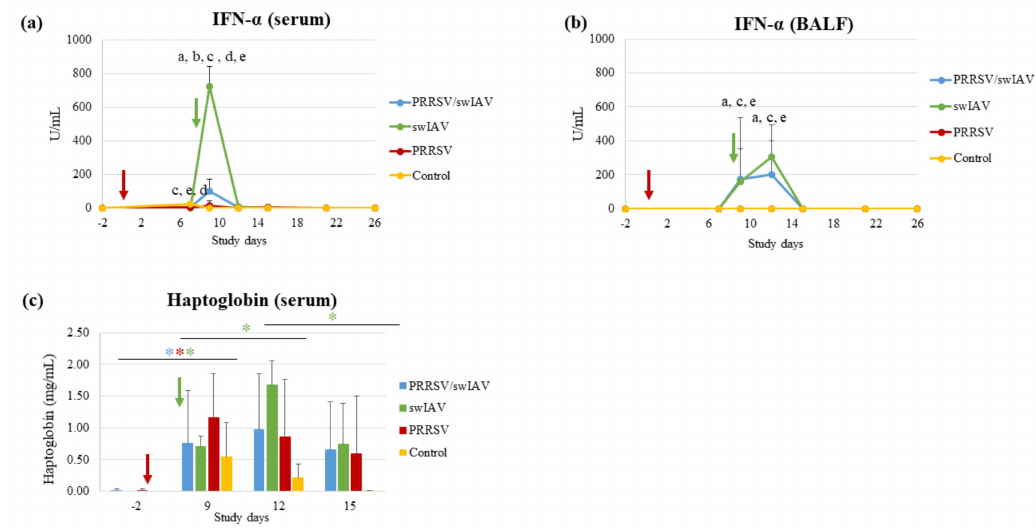
Figure 3. Quantification of IFN- α and haptoglobin. ( a ) Concentration of IFN- α in serum. ( b ) Concentration of IFN- α in BALF. ( c ) Concentration of haptoglobin in serum. All data are reported as the mean ( ± standard deviation) of results obtained from pigs ( n = 6) in the PRRSV/swIAV (blue), PRRSV (red), swIAV (green) or Control (yellow) groups. Letters indicate that significant differences (with p < 0.05) were obtained between PRRSV/swIAV and (a) PRRSV and (b) swIAV and (c) Control groups, (d) and (e) significant difference between PRRSV and swIAV and Control groups (respectively).*: p < 0.05 comparing one time point to another within one group, * PRRSV/swIAV; * swIAV; * PRRSV. SD0 (red arrow): PRRSV inoculation; SD8 (green arrow): swIAV